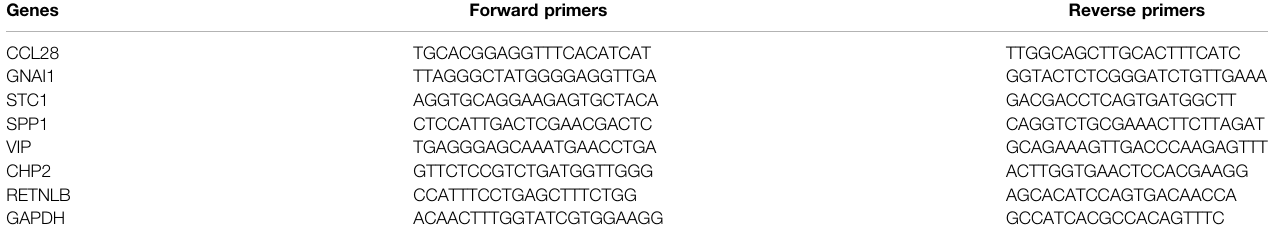
TABLE 1 | The primers of genes. Genes